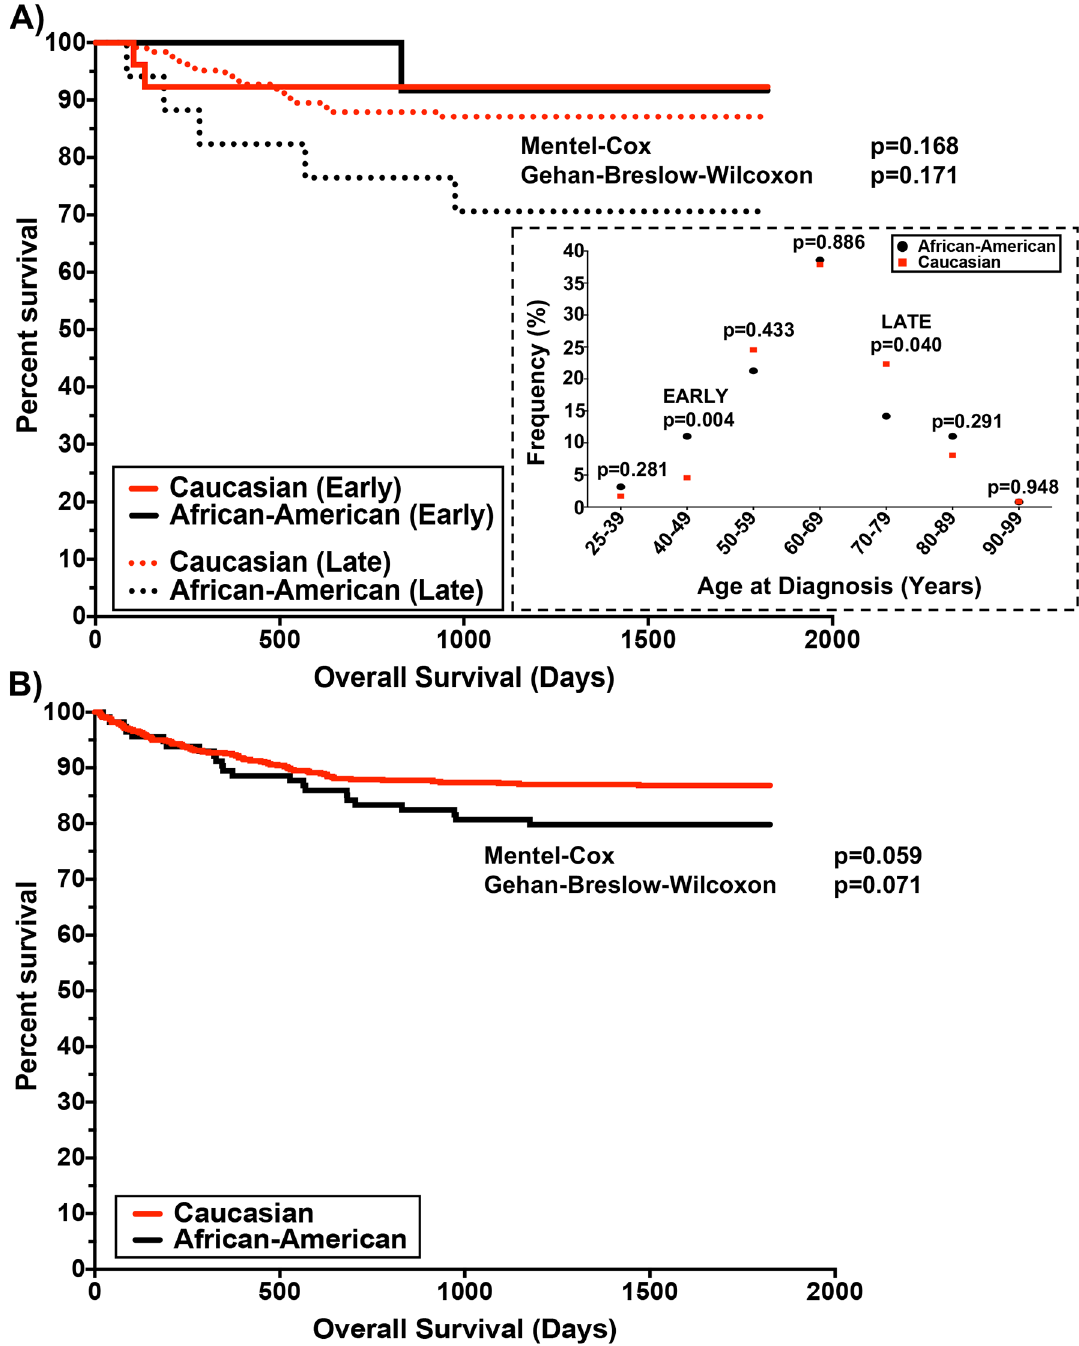
Fig 2. Overall survival of patients based upon age of MM onset and race . (A) Kaplan-Meier analysiswith long-ranktest for overall survival data from CoMMpass IA9 cases stratified by the impact of the early or late onset of MM. The data in the black box demonstrate the distribution of onset across the IA9 data set. The early (term used to label onset between40–49 years), and late (term used to label onset between70–79 years) that were significantly different using Fisher’s exact test betweenthe stratified populations.Samples size also summarized in supplemental table (S3 Table) is as following:25–39 [AA (4/127) vs CA (10/591)], 40–49 [AA (14/127)vs CA (27/591)], 50–59 [AA (27/127)vs CA (145/591)], 60–69 [AA (49/127) vs CA (224/591)], 70–79 [AA (118/127) vs CA (132/591)], 80–89 [AA (14/127)vs CA (48/591)], 90–99[AA (1/127) vs CA (5/ 591)]. (B) Kaplan-Meier analysiswith long-ranktest for overall survival data from CoMMpass IA9 impact of incidentsof MM by